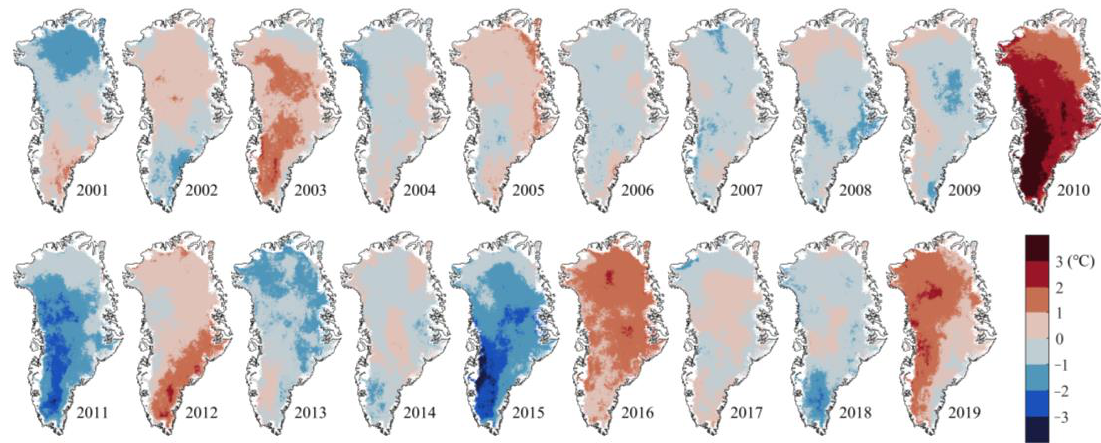
Figure 6. Annual IST anomalies (°C) calculated from monthly-derived MODIS IST.